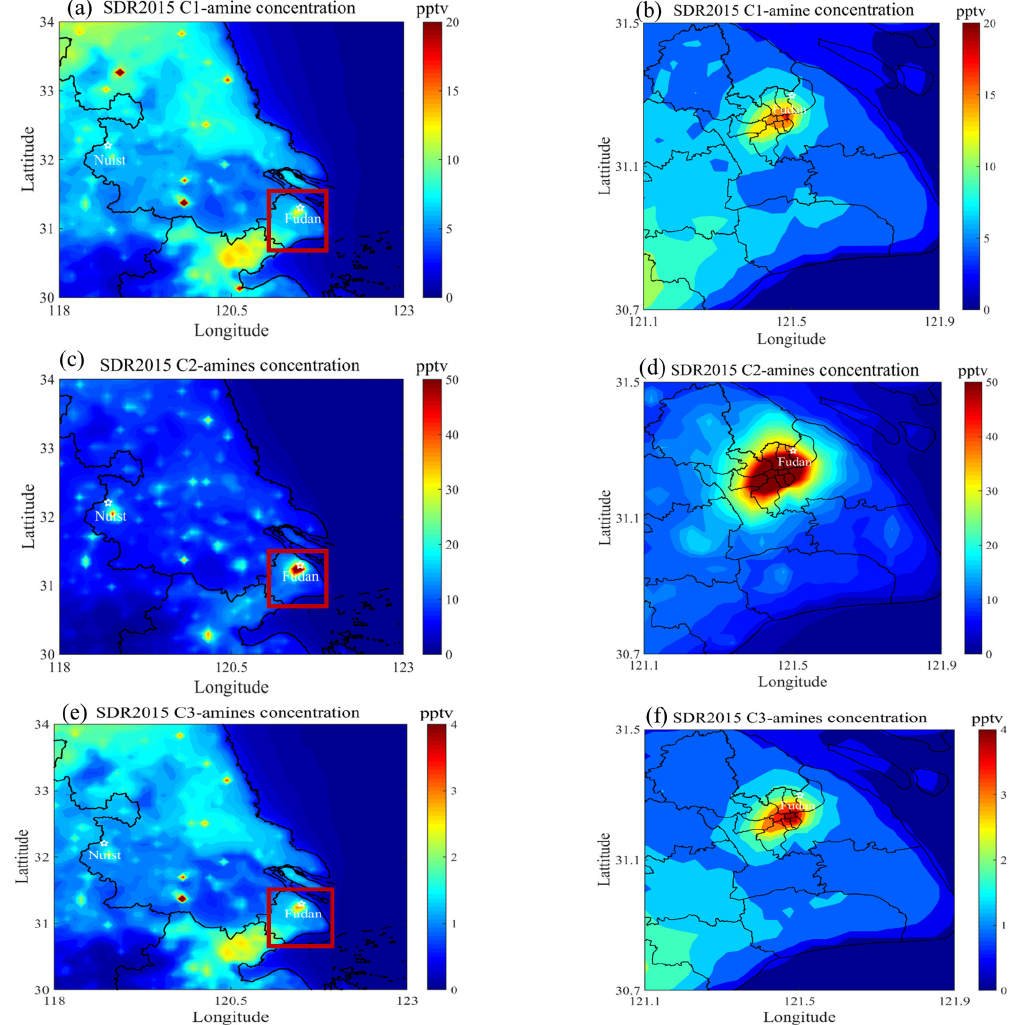
Figure 12. Simulated horizontal distributions of mean concentrations of C1-, C2-, and C3-amines in domain 3 and domain 4 during the period of 25 July to 25 August 2015 (SDR2015 case).